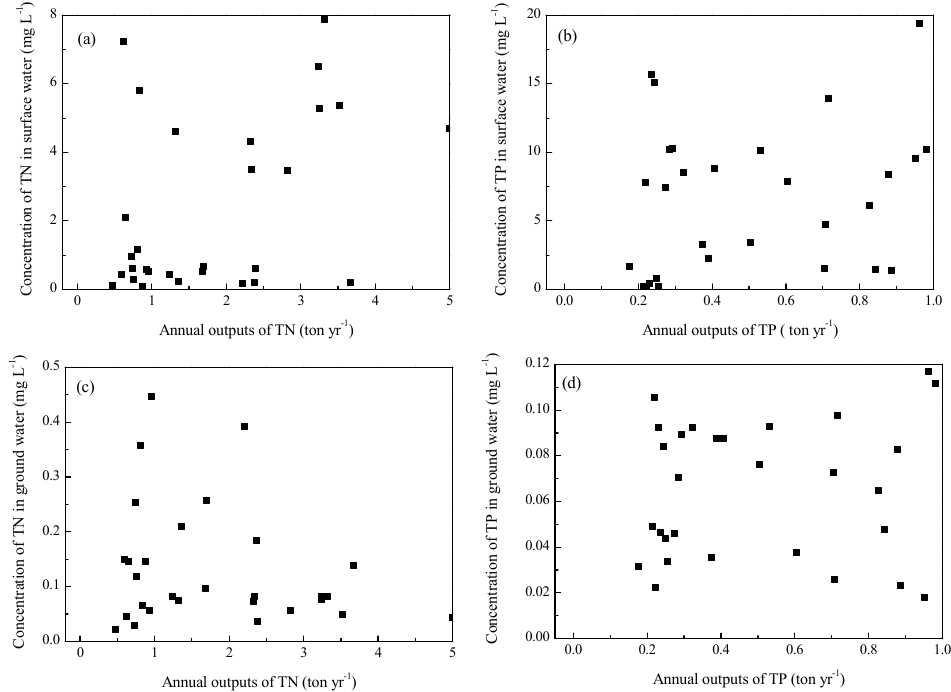
Figure 5. The concentrations of TN and TP in surface and ground water response to the annual outputs of pollutants from pig farms. ( a ) The relationship between annual outputs of TN and concentration of TN in surface water ( b ) The relationship between annual outputs of TP and concentration of TP in surface water ( c ) The relationship between annual outputs of TN and concentration of TN in ground water ( d ) The relationship between annual outputs of TP and concentration of TP in ground water.